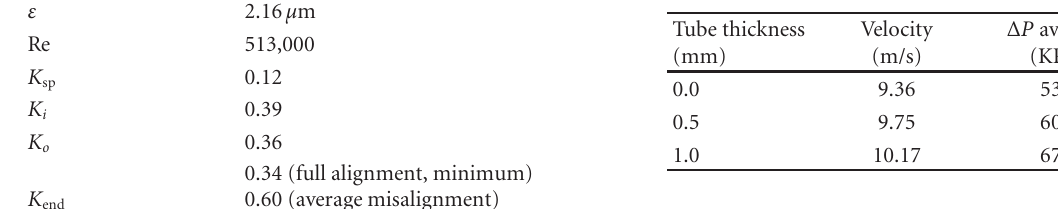
Table 1: Friction terms of CANDU fuel in Embalse conditions. F